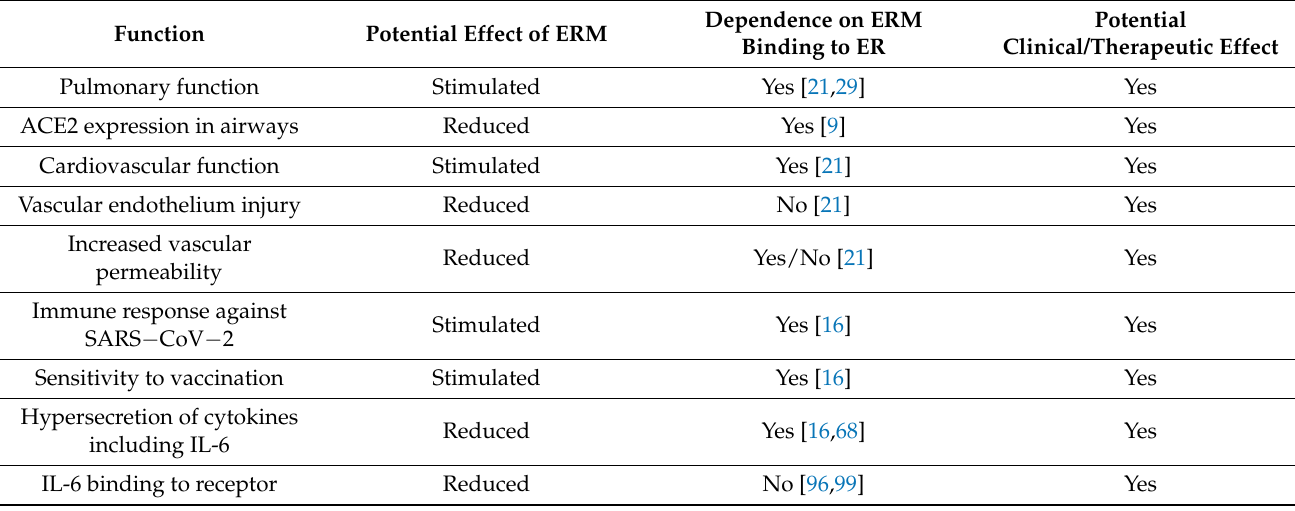
Table 3. Summarization of the potential role of ERMs including estrogen in